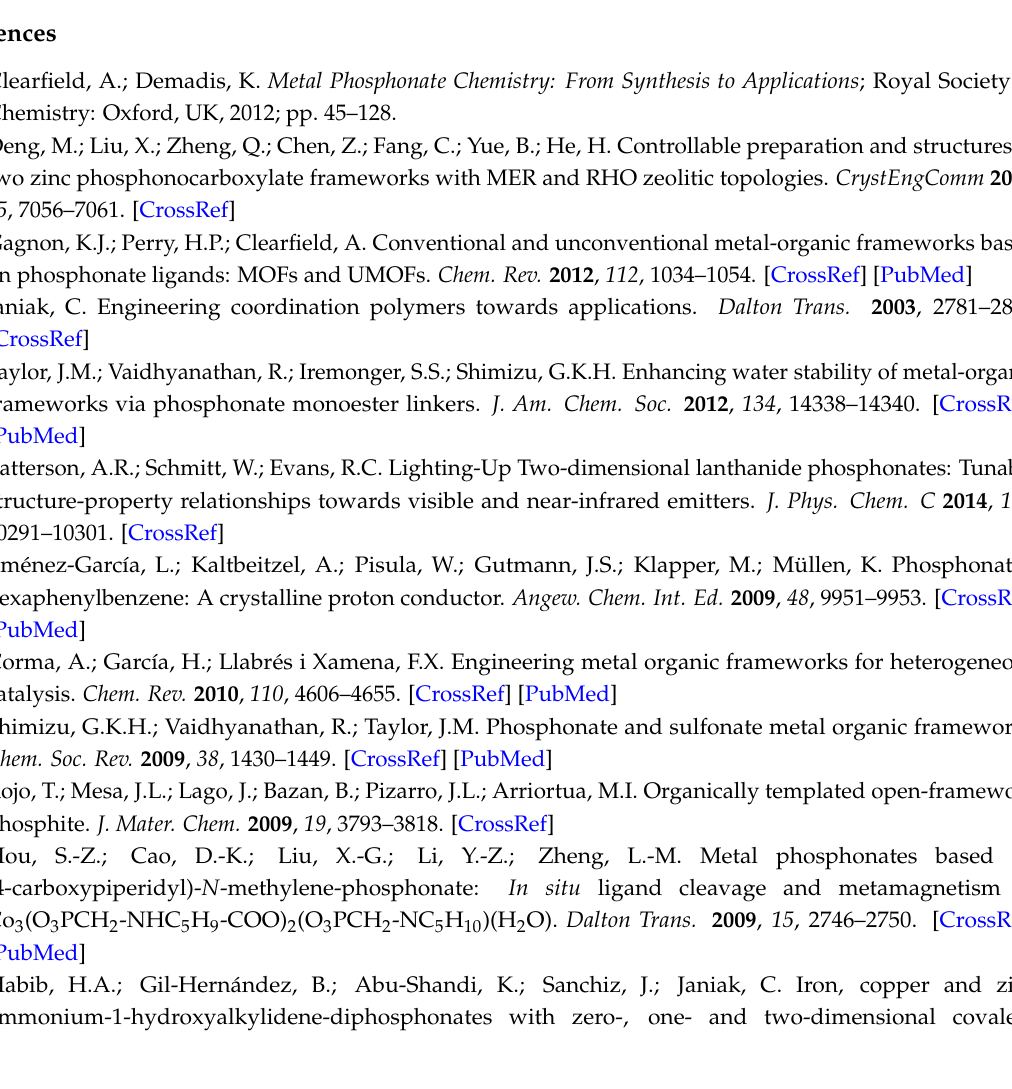
Figure S1: Photographs of crystals of (a) NH 4 (HO 3 P-(C 6 H 4 ) 2 -COOH)(H 2 O 3 P-(C 6 H 4 ) 2 -COOH), 1 and (b) [Co(NH 3 ) 6 ](O 3 P-(C 6 H 4 ) 2 -COO) ¨ 4H 2 O, 2 taken with a light microscope; Figure S2: FT-IR (ATR) spectrum of NH 4 (HO 3 P-(C 6 H 4 ) 2 -COOH)(H 2 O 3 P-(C 6 H 4 ) 2 -COOH), 1 ; Figure S3: FT-IR (ATR) spectrum of [Co(NH 3 ) 6 ](O 3 P-(C 6 H 4 ) 2 -COO) ¨ 4H 2 O, 2 . Figure S4: Comparison of the experimental PXRD pattern of 1 (black) with the simulated pattern from the X-ray data (red). Packing